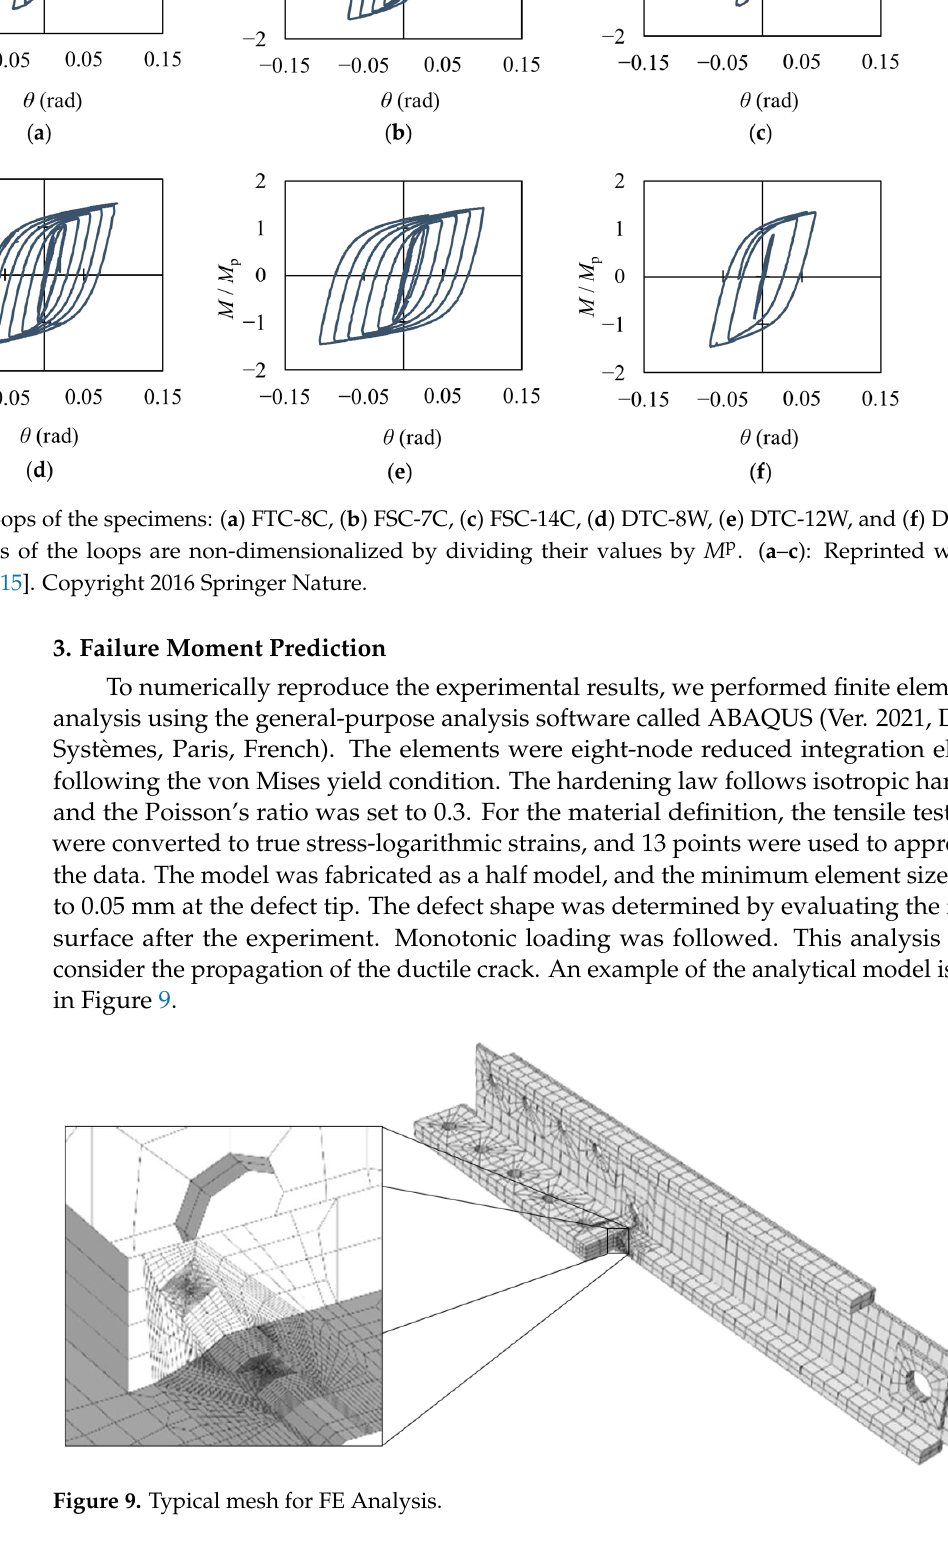
Figure 7. Fracture surfaces of the ( a ) FTC-8C and ( b ) FSC-14C specimens. Figure 8 shows the hysteresis loops obtained from the experiments.